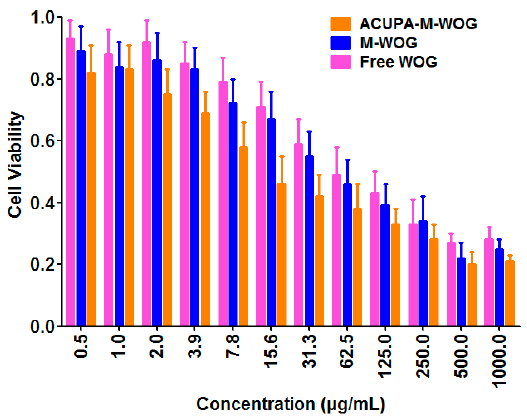
Figure 5. The cytotoxicity of the free WOG, M-WOG, and ACUPA-M-WOG on LNCaP in vitro . The cell viability is quantified by MTT through detecting the percentage of viable cells. Mean values and 95% confidence intervals are shown, which are depended on three independent experiments.